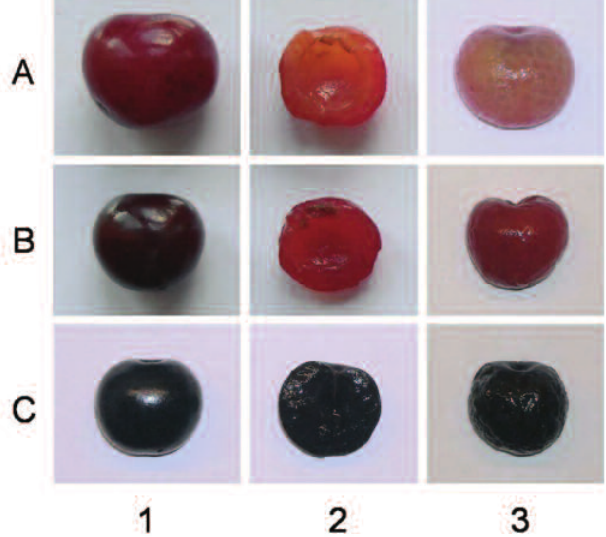
Figure 2. Visual appearance of different sour cherry types tested in the present study.A: ‘Pipacs 1’, B: ‘Újfehértói fürtös’, C:VN-01; 1: intact fruits, 2: stone cavity of halved fruits, 3: peeled